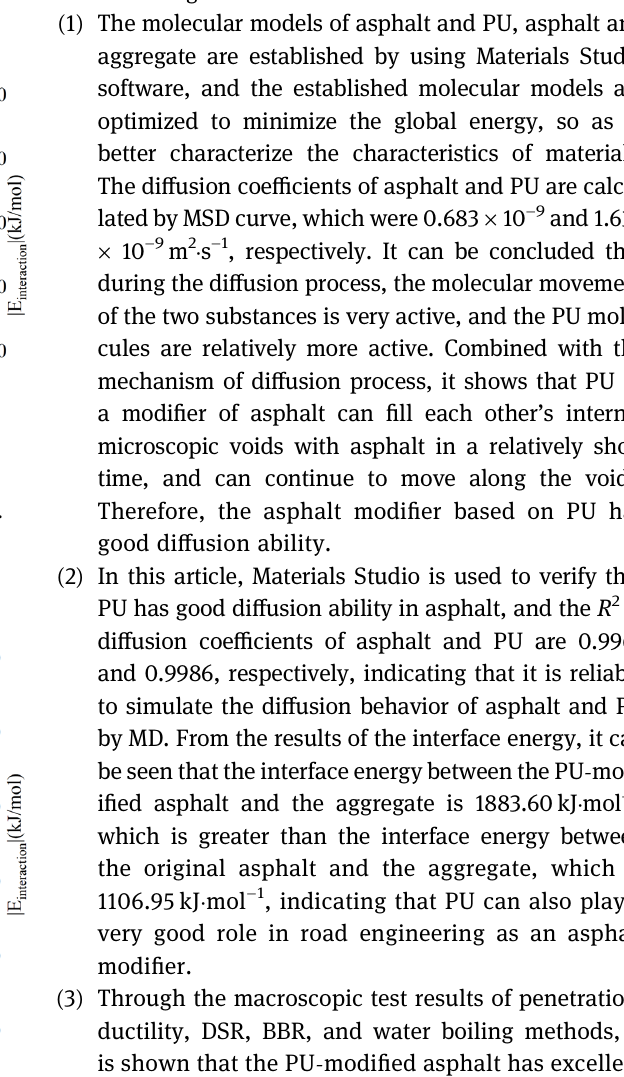
Figure 24: Veri fi cation of boiled test results and simulation results.